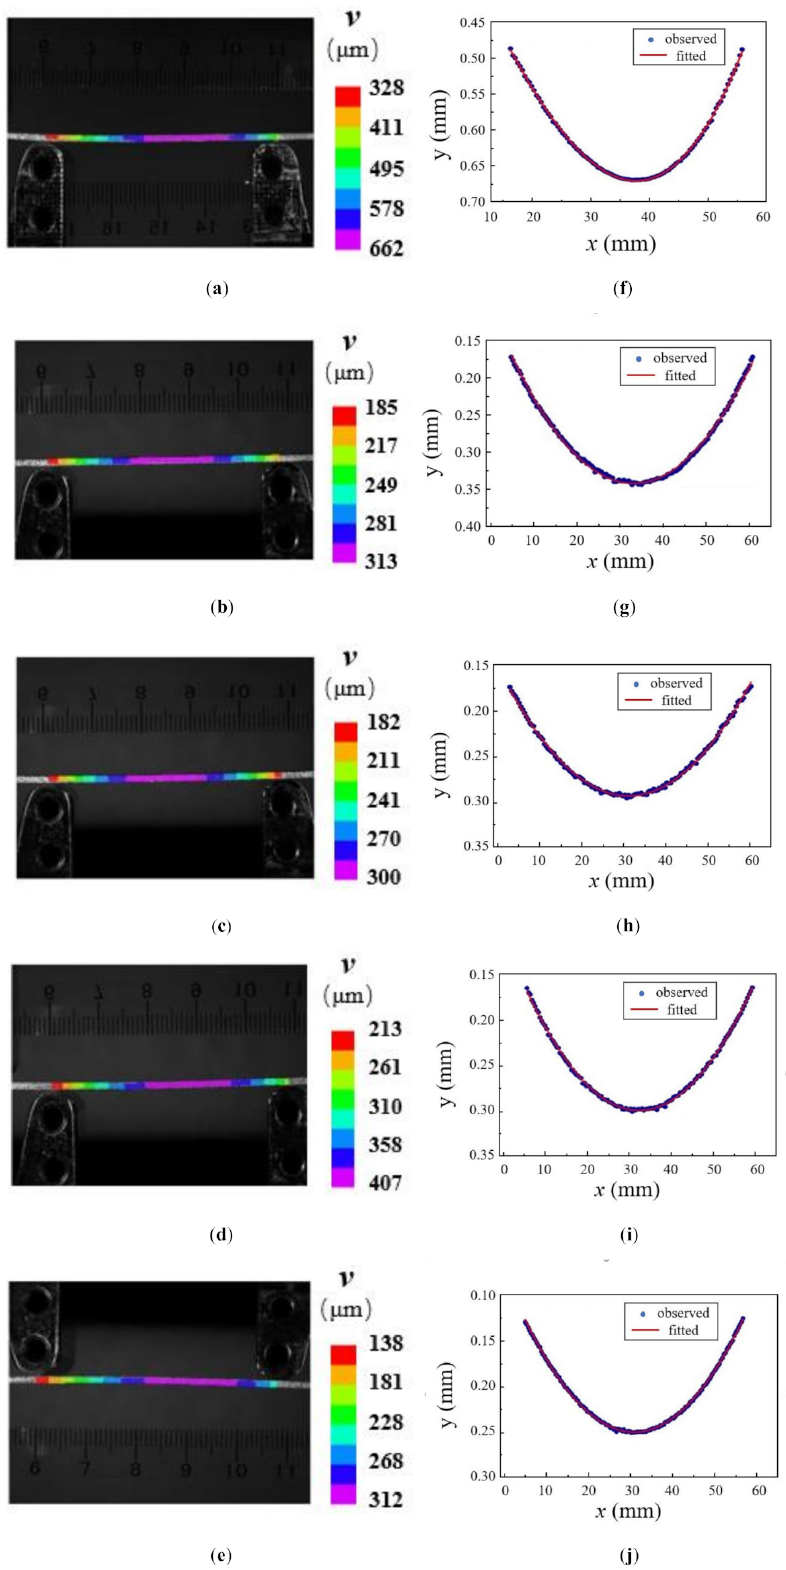
Figure 10. Vertical deformation of the topcoat-upward specimens under four-point bending measured by 3D DIC. The loading P is equal to 5 N. ( a – e ) are vertical deformation fields of specimens with high temperature exposure for 0, 2, 5, 10 and 20 h, respectively, and ( f – j ) are their corresponding fitting